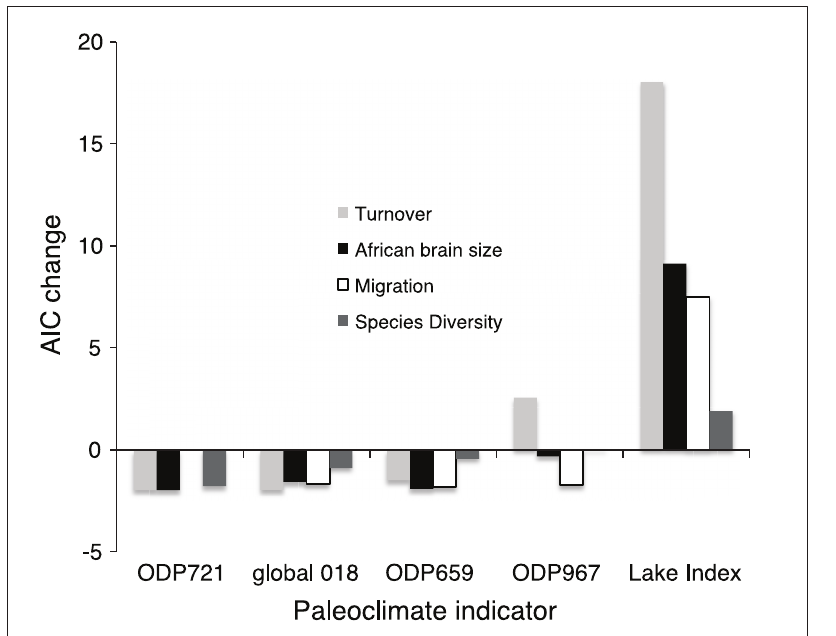
Figure 2. Relative impact on model fit of different paleoclimate indicators as predictors of aspects of African hominin evolution (species turnover, brain size change, dispersal events, and overall diversity). Values represent the deltaAIC change [38] from dropping each of the indicators from the global model. ODP721 was not incuded in the migration analyses due to a high VIF. Non-climate variables included in these models are not shown here as they vary across analyses but can be found in File S1.